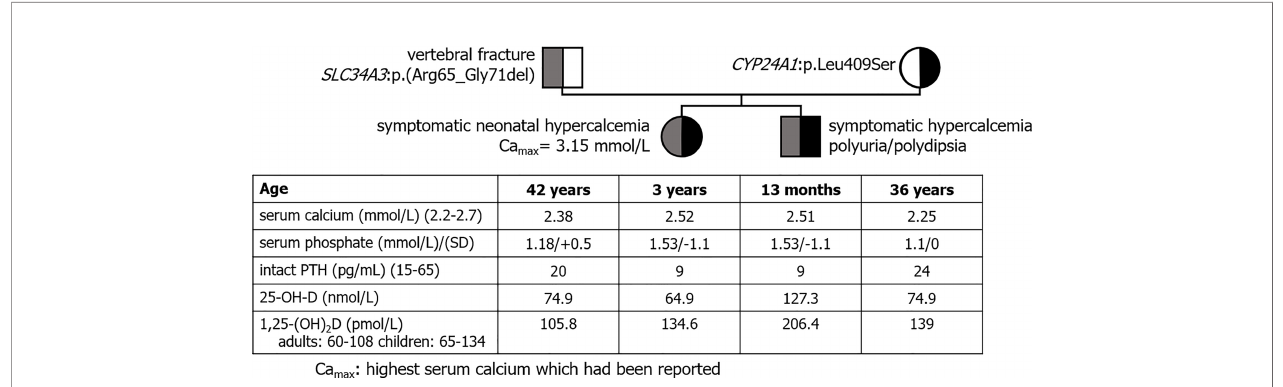
nephrocalcinosis (n=2) and 4 patients with biallelic SLC34A1 variations, 2 of them (patients 103 and 170) having nephrocalcinosis detected as hyperechogenic kidney in utero (21). Hypophosphatemia (serum phosphate Z-score < -2) was reported in 7 patients (27-28%) with CYP24A1 biallelic mutations and 1 patient with SLC34A3 biallelic mutations ( Figure 2 , Table 3 and Supplementary Table S1 ). Serum calcium in patients with biallelic SLC34A3 mutation was (p=0.0123*). Serum 25-OH-D in patients with biallelic CYP24A1